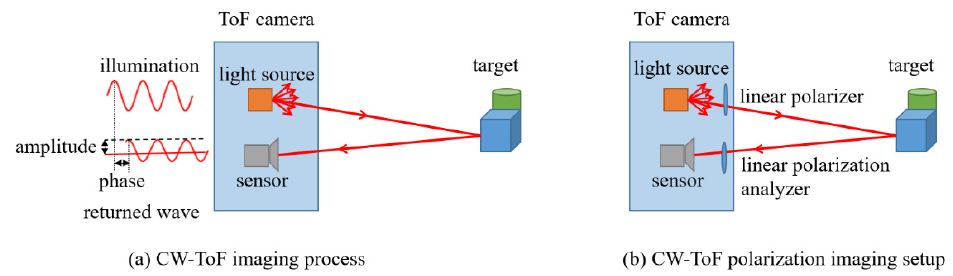
Figure 3. The CW-ToF imaging process and polarization imaging setup. ( a ) The light of a CW-ToF camera is modulated with continuous wave, and a CW-ToF camera simultaneously acquires the amplitude and depth of a scene. ( b ) The linear polarizers are added in CW-ToF imaging system, which constitutes the polarization imaging